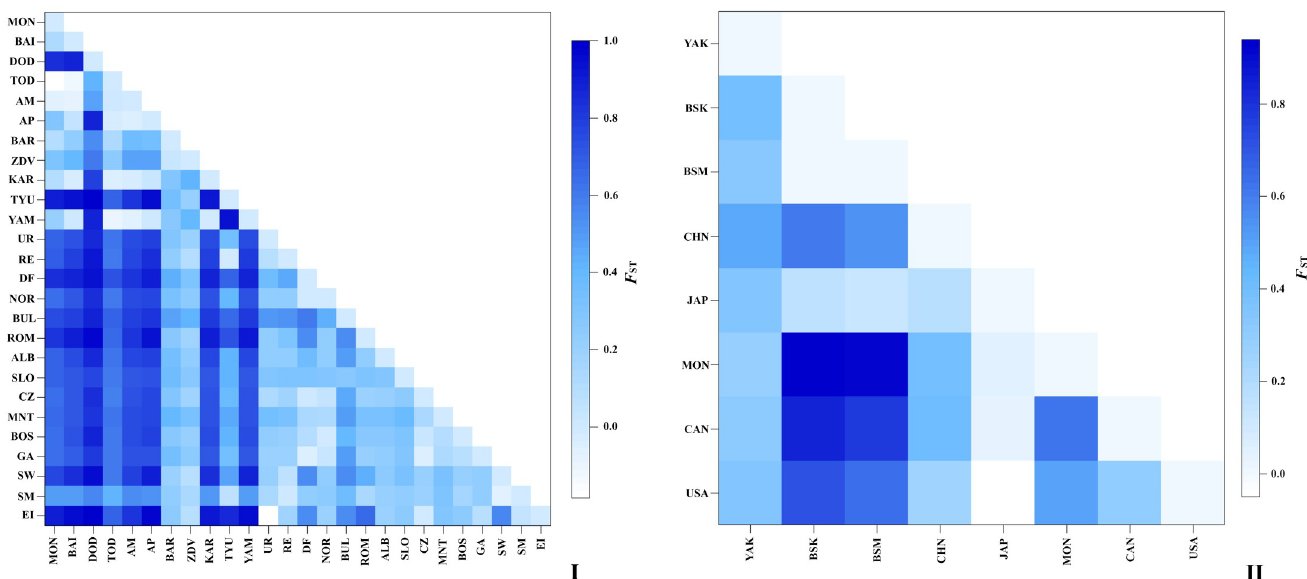
Fig 5. Graph of pairwise F ST distance matrices between geographical populations of D . longispina (I) and D . dentifera (II). Codes are the same as in S3 and S4.